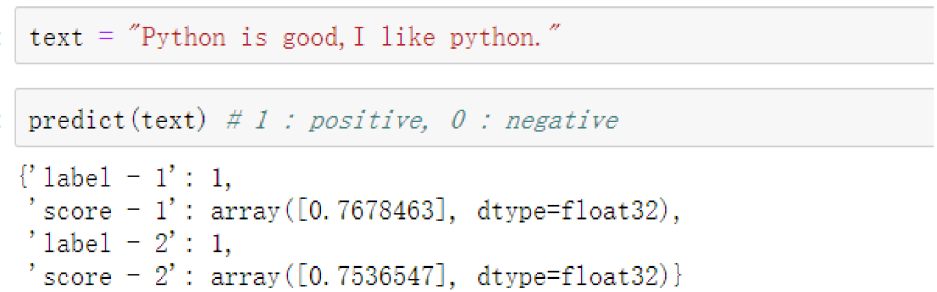
Fig. 12 Comparison of sentiment analysis results based on LSTM and